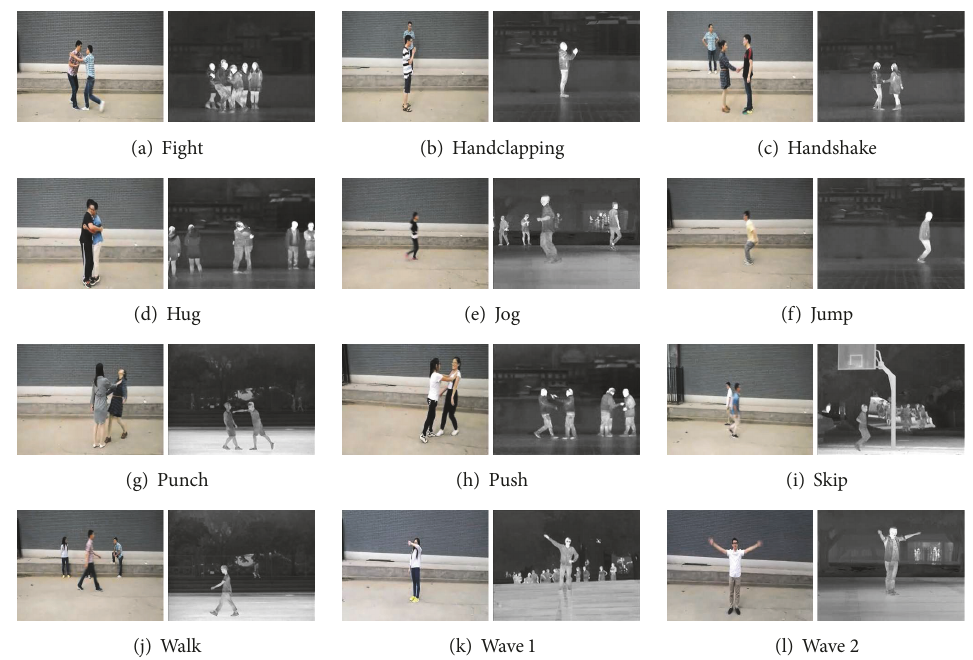
Figure 6: Comparison of visible and infrared actions. The left of each subfigure is the visible image from video sequences in the XD145 dataset, while the right is the infrared image from video sequences in the InfAR